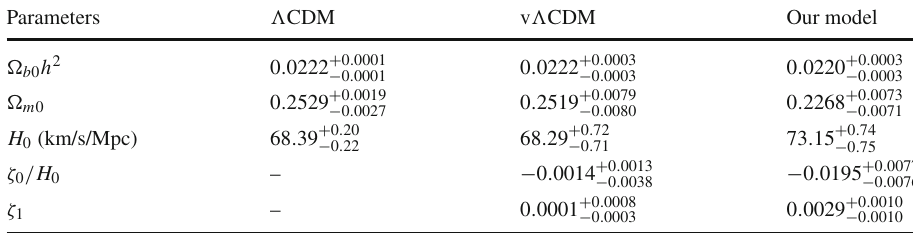
Table 1 Best-fitted parameters for (cid:2) CDM, v (cid:2) CDM, and our viscous model in f ( T ) gravity